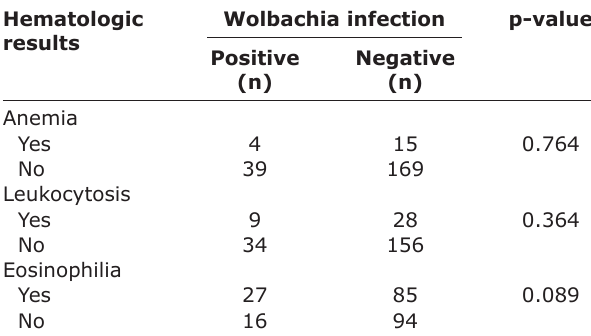
Table-5: Association of hematological parameters and Wolbachia infection in pet and semi-domesticated cats. Hematologic